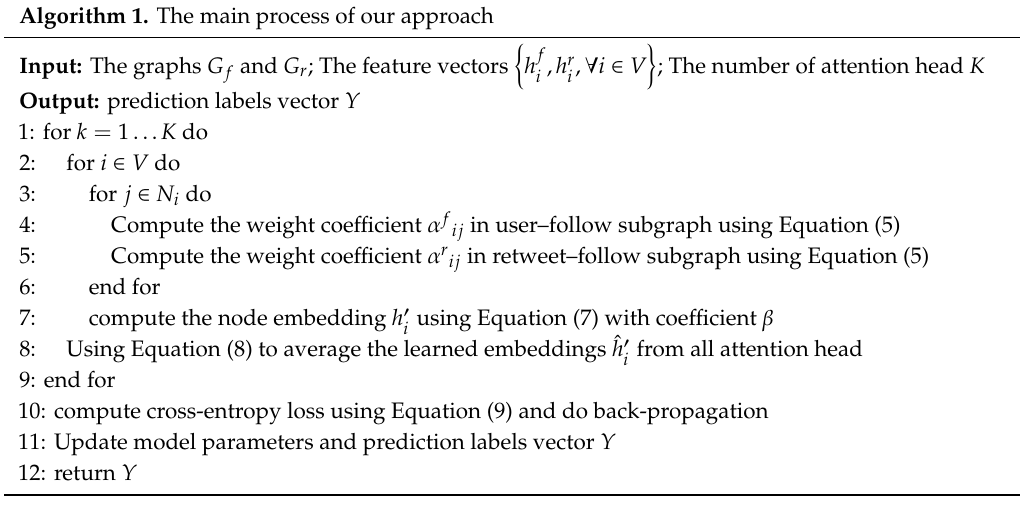
Algorithm 1. The main process of our approach